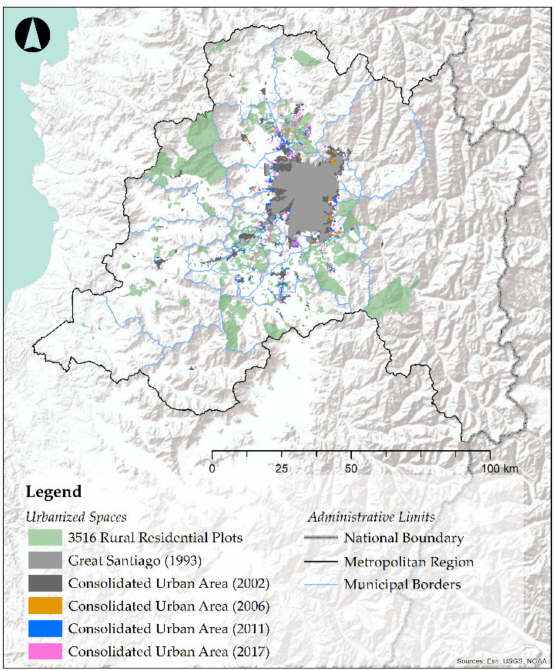
Figure 2. Expansion of urban and residential spaces in MR (1980–2017). Source: Own elaboration, based on the Ministry of Housing and Urban Development (MINVU,